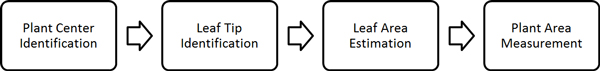
Workflow of Plant Area Estimation (PAE).